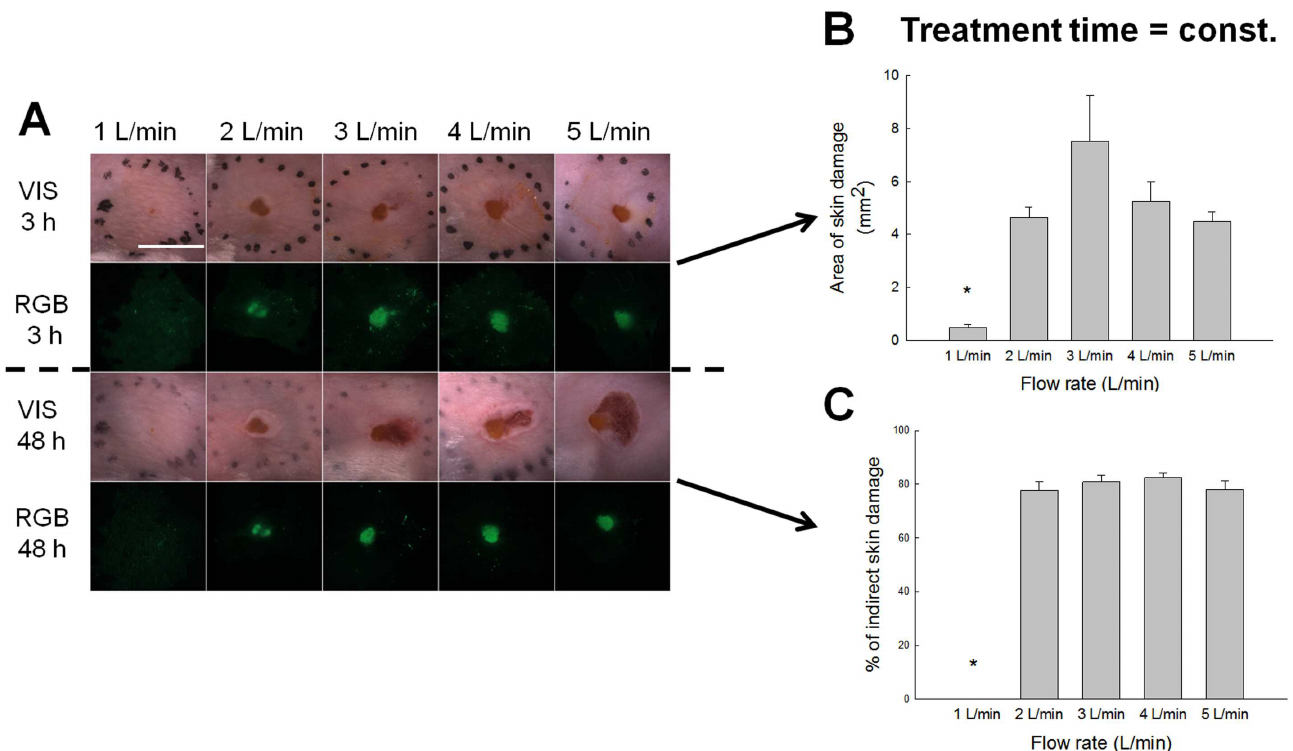
Fig 3. Skin damage observed under different plasma flow rates. A) Representative images of the skin damagein the treated region. Treated skin regions were observedunder stereomicroscope. Images were taken under visiblelight (VIS) and the fluorescence was observedunder RGB (red, green, blue) parameters.Scale bar: 5 mm. B) The area of the direct skin damagewas evaluatedfrom RGB images. Error bars indicate SEM. * P value < 0.05 betweenthe selectedgroup and the group treated under the highest plasma flow rate (treated 4 min under 5 L/min). C) Percentage of indirect skin damage calculatedfrom the total damage(direct and indirect) measured48 h post-treatment. Damage was statistically evaluatedfrom RGB image. Error bars indicateSEM.